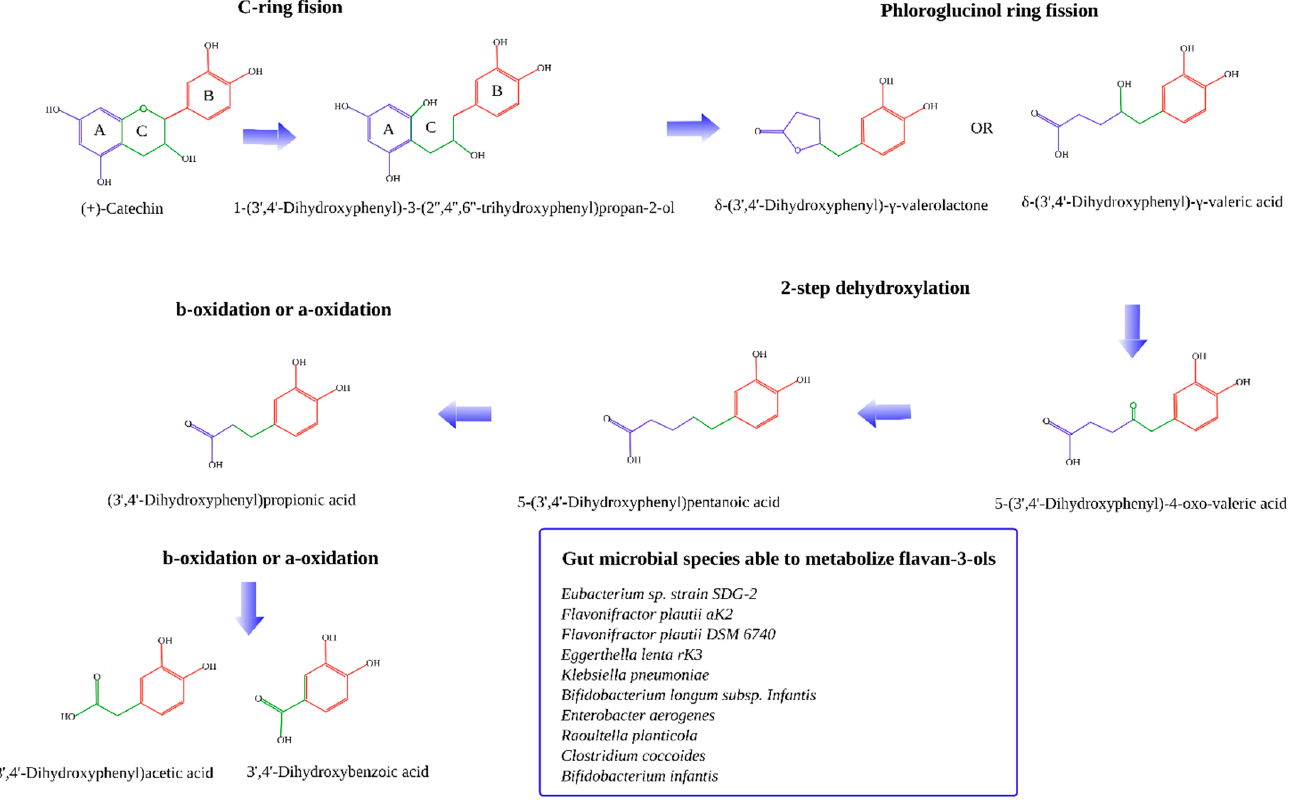
Figure 1. Metabolization of flavan-3-ols by the gut microbiota [7,8,11,32–34].